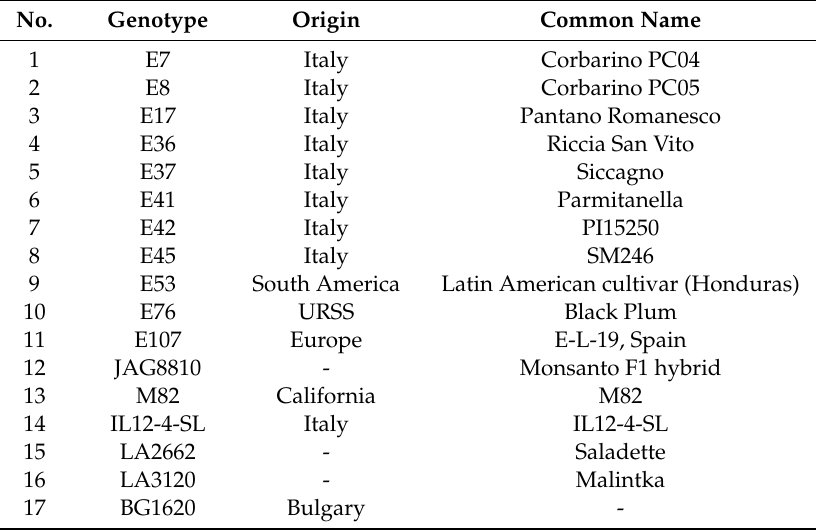
Table 4. Tomato genotypes analyzed in this